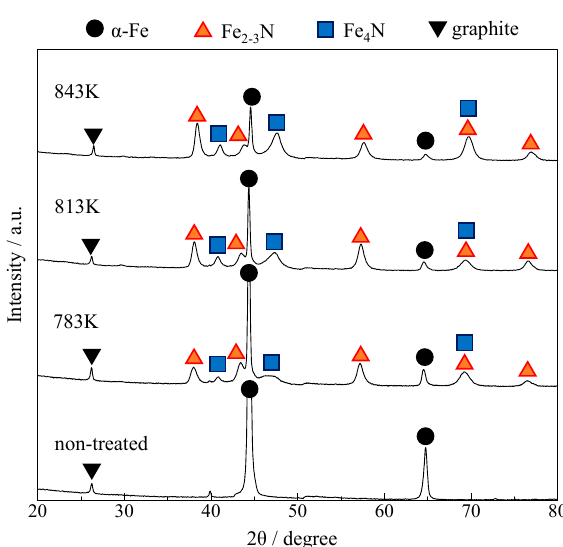
Figure 2. X-ray diffraction patterns of ASPN-treated plate samples.